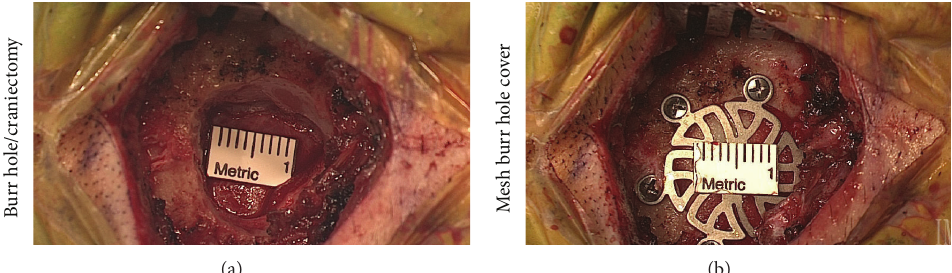
Figure 1: Endoscopic view of burr hole/craniectomy site (a) with subsequent closure and placement of titanium mesh burr hole cover